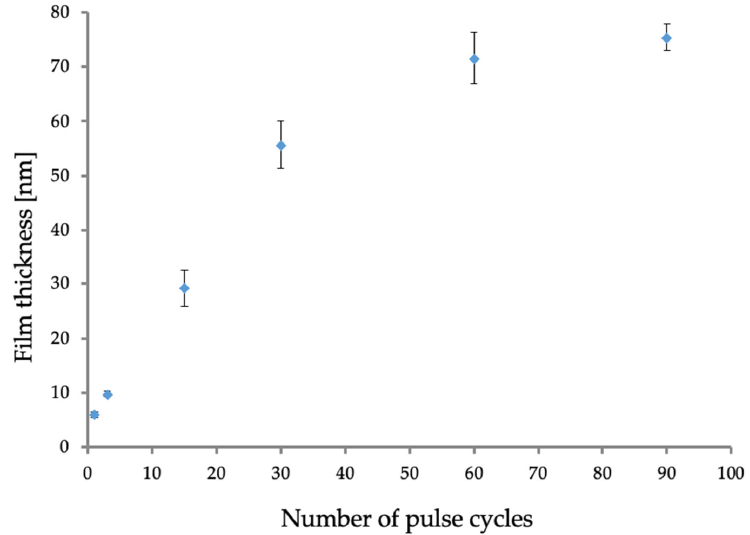
Figure 4. Thickness of the PDA films in dependence of number of pulse cycles. The error bars correspond to ±1 standard deviation over 5 thickness measurements.